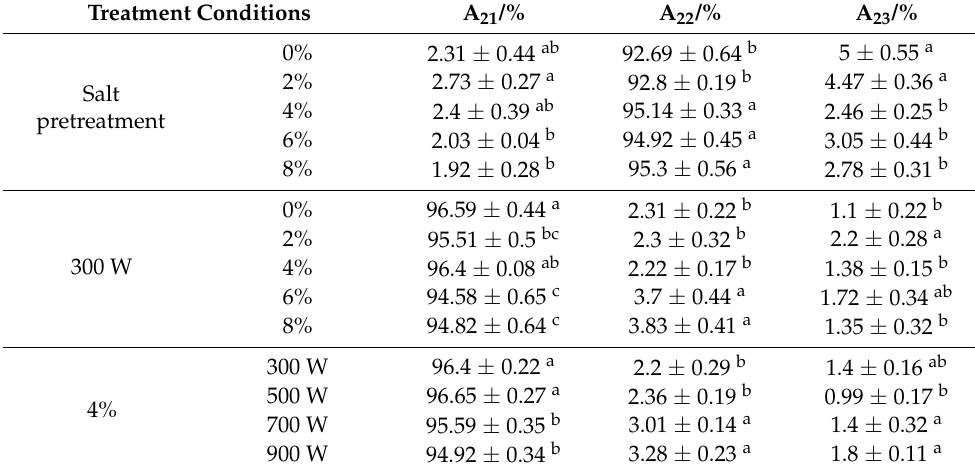
Figure 2. T 2 relaxation time distribution curves of dried shrimps by different drying treatments: fresh shrimps with different salt concentrations ( a ), dried shrimps with different salt concentrations ( b ), dried shrimps with different MW powers ( c ). Table 1. Peak area relaxation populations of dried shrimps with different salt concentrations and MW